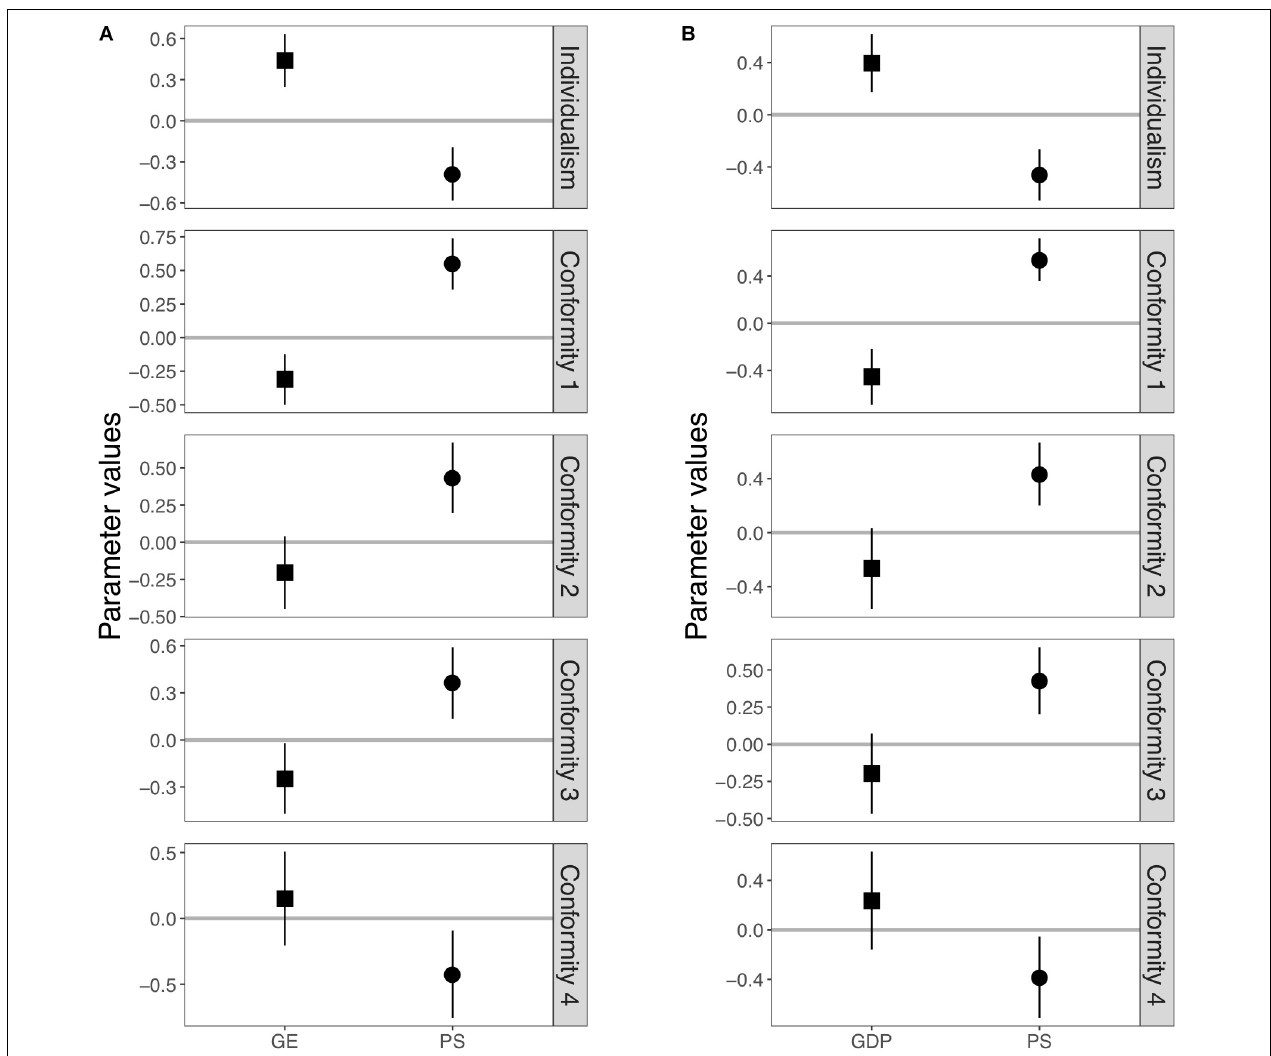
FIGURE 1 | Posterior distributions of the estimated values of slopes in Model 1. (A) Results using government effectiveness as an independent variable. (B) Results using GDP per capita as an independent variable instead of government effectiveness. Squares and circles represent posterior mean of slope affecting government effectiveness (or GDP per capita) and pathogen stress, respectively. Each error bar represents a 95% Bayesian credible